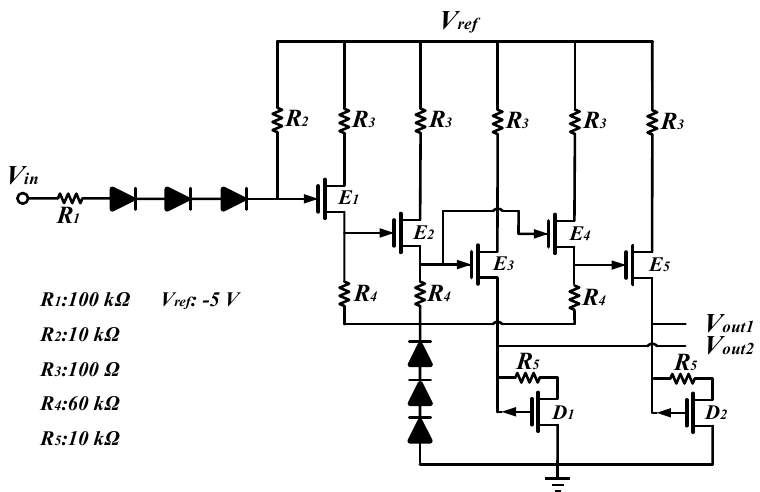
Figure 14. The schematic of the designed logic control circuit.